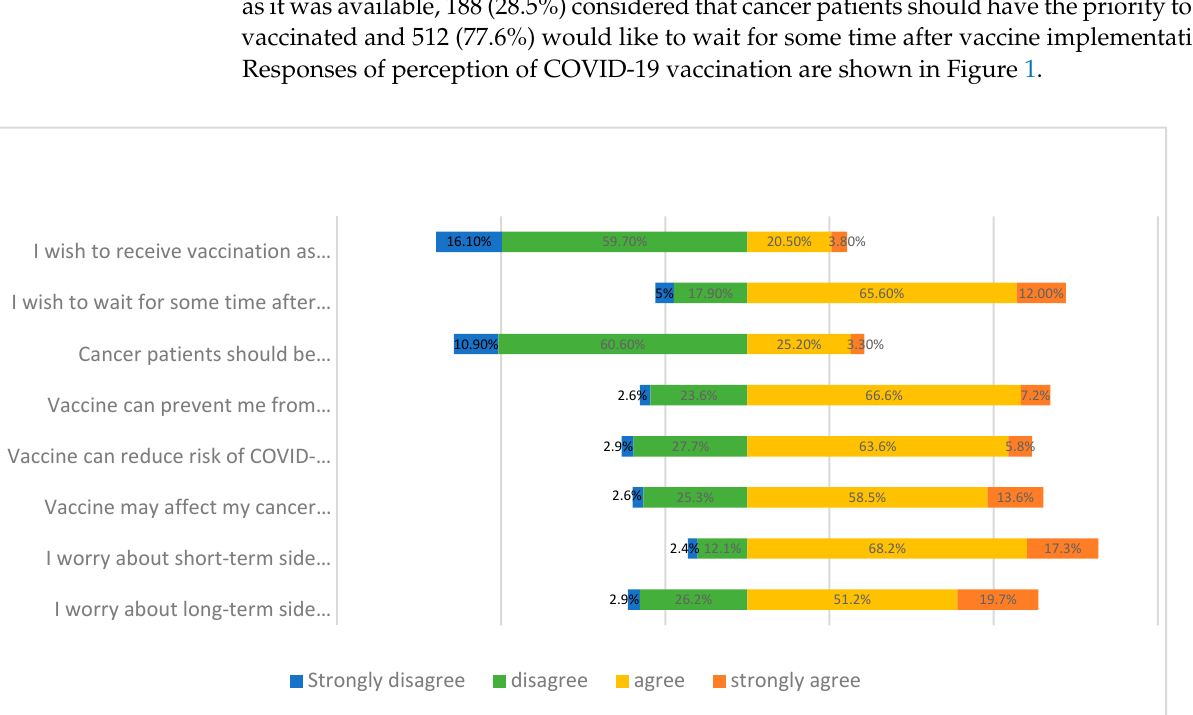
Figure 1. Perception of cancer patients on COVID-19 vaccination. In univariable analysis, a significantly higher proportion of participants who were male, did not have private medical insurance, had a lower level of cancer health literacy and had normal HADS depression score (<11) were more willing to get vaccinated than the participants who were female, had medical insurance, higher level of cancer health literacy and had high HADS depression score (Table